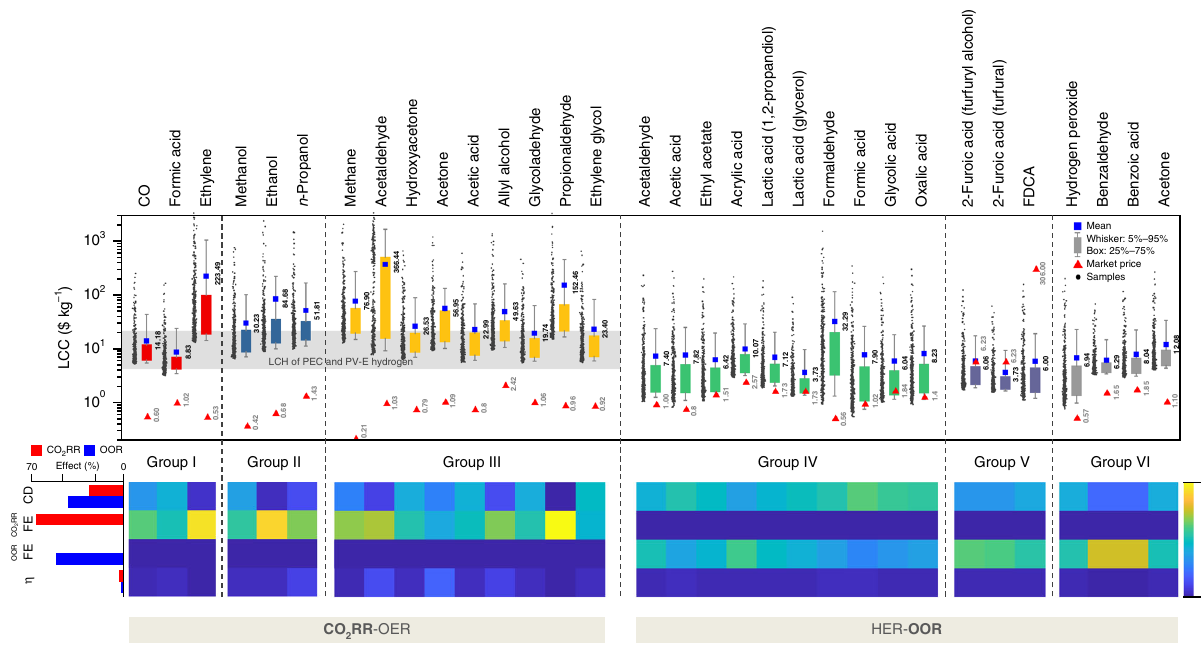
Fig. 4 Levelized cost of chemicals distribution and global sensitivity analysis. Whole target products of CO 2 RR – OER and HER – OOR are compared with their market price determined via GSA through current density, FE (cathode and anode), and overpotential. The light gray band represents the levelized cost of hydrogen ($5.5 – 12.1 kg − 1 ) with various types of PEC and PV-E technology 22